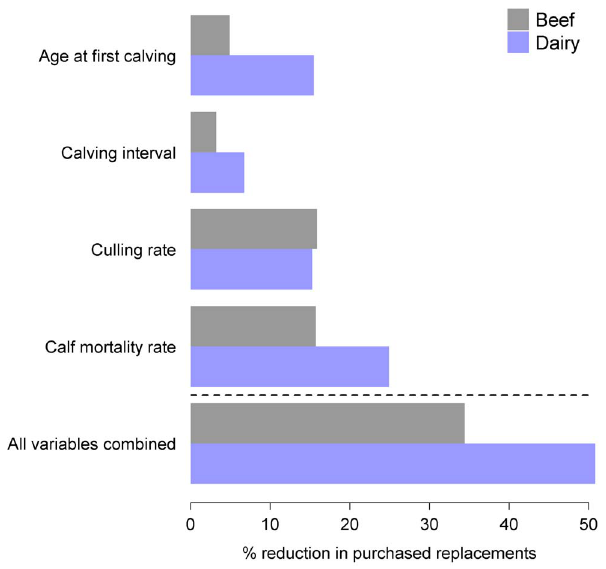
Figure 3. Estimated reduction in the endemic prevalence of BVDV following removal of replacement breeding cattle movements. The proportion of movements removed from the network was varied randomly between 0 and 13.3% at the beginning of each simulation. The black dots indicate the results from removing movements from the network at random. The blue dots indicate the results for the targeted removal of replacement breeding cattle movements. A total of 10,000 replicates were performed for each removal strategy. The transmission probability was set at 0.05 and the infectious period half-life was set at 1,095 days to simulate BVDV.